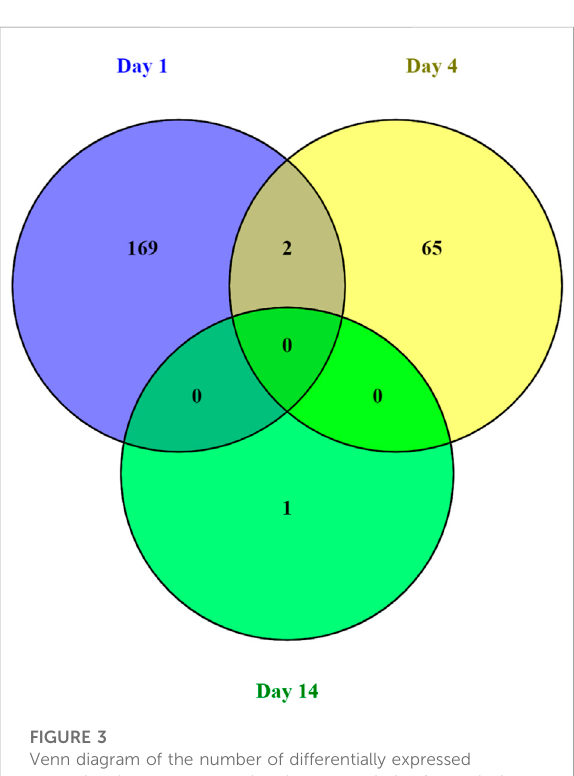
FIGURE 3 Venn diagram of the number of differentially expressed transcripts between weaned and unweaned pigs for each time point (Qval ≤ 0.1 & FC ≥